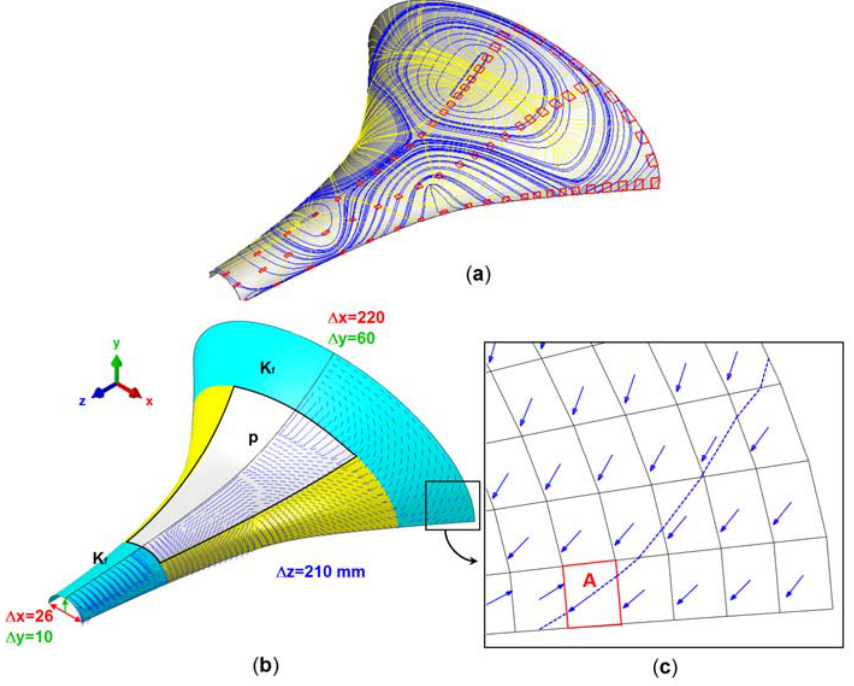
Figure 1. Shell under lateral pressure p = 0.15 MPa, bedded elastically (K f = 1000 N/mm); typical dimensions Δ x, Δ y, and Δ z, modulus E = 50 GPa, thickness t = 2 mm. ( a ) stress trajectories, standard integration begins in the red start elements; ( b ) PS directions from a linear static analysis; ( c ) detail, standard integration begins in element A. Improved accuracy is gained with mesh refinement.